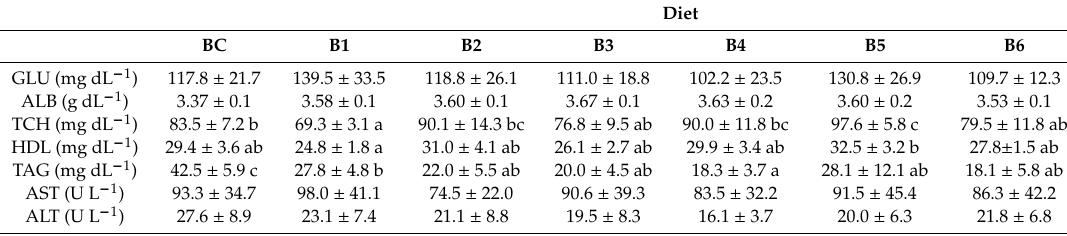
and seeds; B3—bread enriched with hazel nuts, seeds, and amaranth flour; B4—bread enriched with milk, amaranth flour, and seeds; B5—bread enriched with amaranth flour, seeds, yolk, and carum; B6—bread enriched with